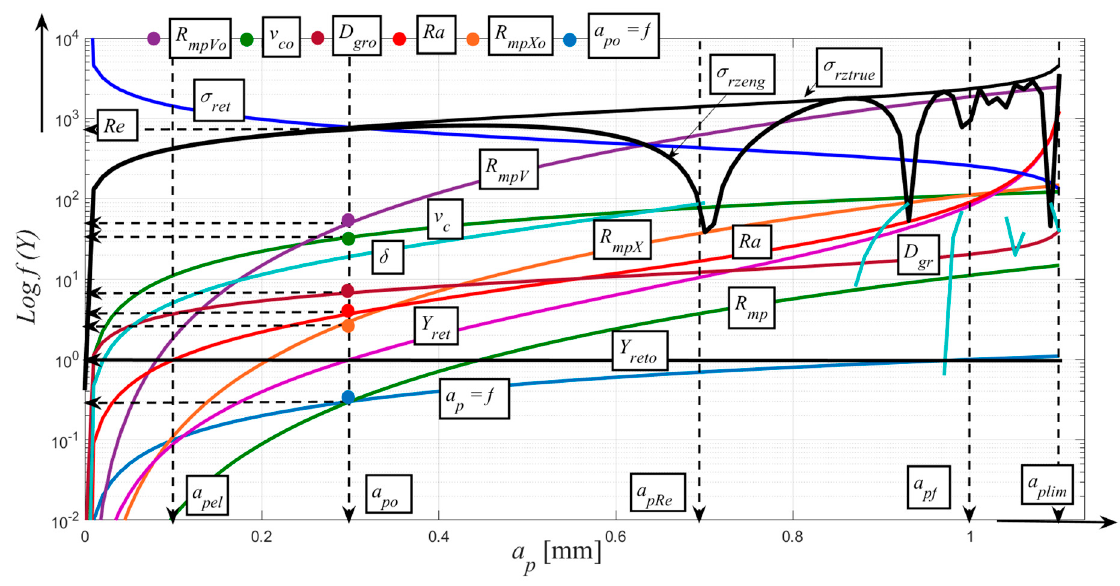
Figure 4. Relation R mp for Stellite material.